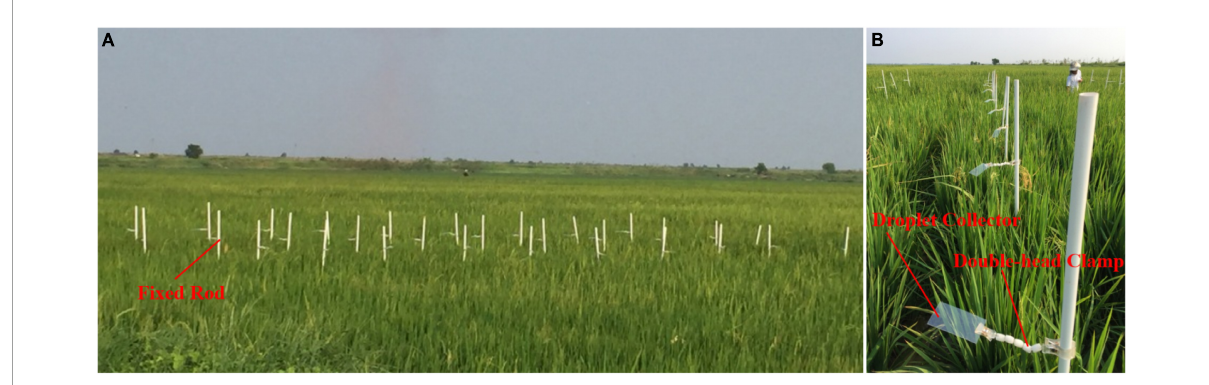
FIGURE6 Rice pesticide application test site. (A) Represents the field sampling site of rice field, where the sampling points are arranged on the fixed rod. (B) Represents a partial schematic of each fixed rod, where the double-head clamp connects the fixed rod to the droplet collector.